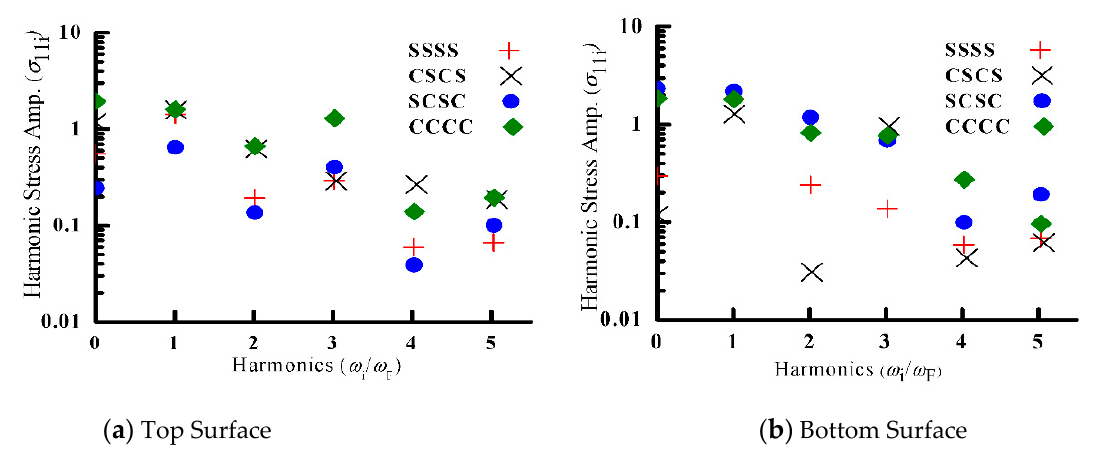
Figure 5. Fast Fourier transform of nonlinear periodic stress ( σ 11 ) corresponding to Figure 4.